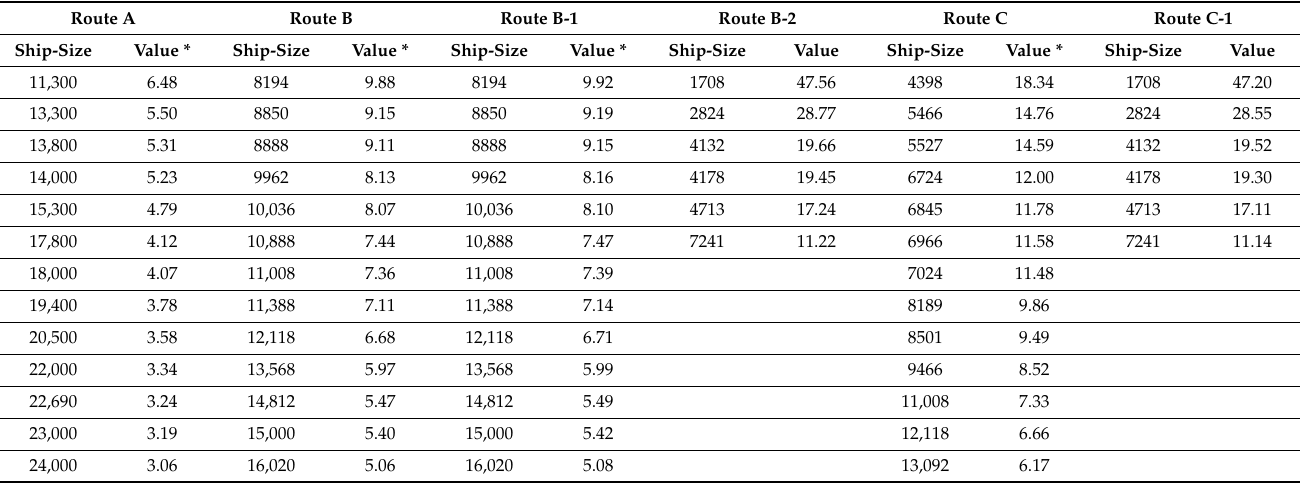
Table 5. Carbon Intensity on Different Trunk Routes and